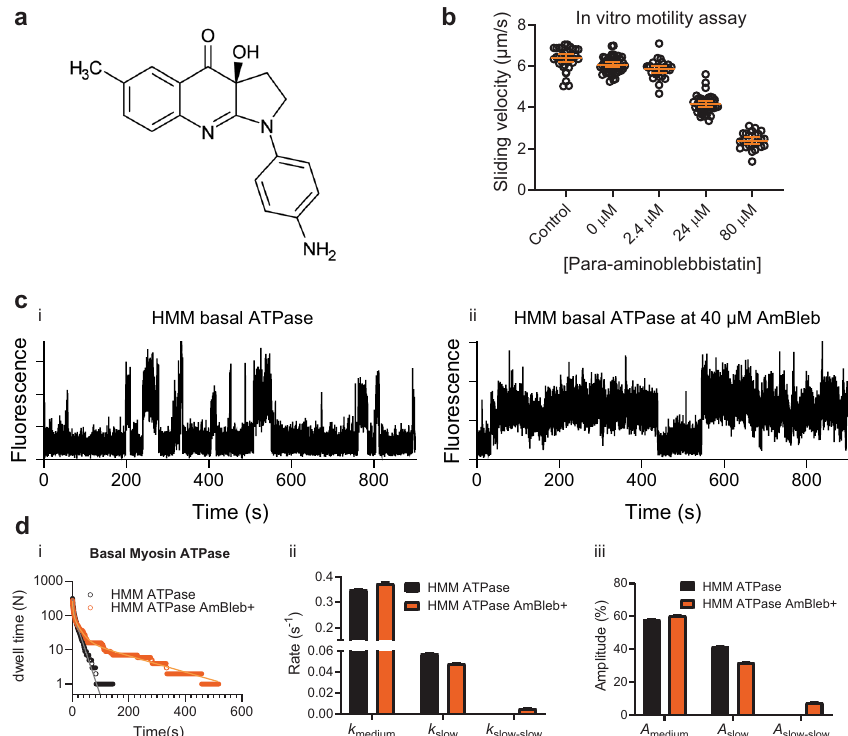
Fig. 6 Effect of AmBleb on single molecule ATPase. a The molecular structure of para-aminoblebbistatin (AmBleb) is shown 39 . b Concentration – response curve for effect of AmBleb on sliding velocity at 60 mM ionic strength (1 mM MgATP) is shown using HMM. c Representative time traces of single molecule basal HMM ATPase without (i) or with 40 µ M AmBleb (ii). Note two long dwell time events as direct consequence of effect of AmBleb on basal ATPase activity. d Cumulative dwell time distributions (i) of basal HMM ATPase in the absence and presence of 40 µ M AmBleb were best fi tted to double (control, data from 19 HMM molecules, N dwell = 318) or triple (AmBleb, data from 31 HMM molecules, N dwell = 280) exponential functions revealing an additional slow phase (ii, iii) with rate constant 0.006 s − 1 (~8%) in the presence of AmBleb. Error estimates refer to 95% con fi dence intervals derived in the regression analysis. Temperature: 20